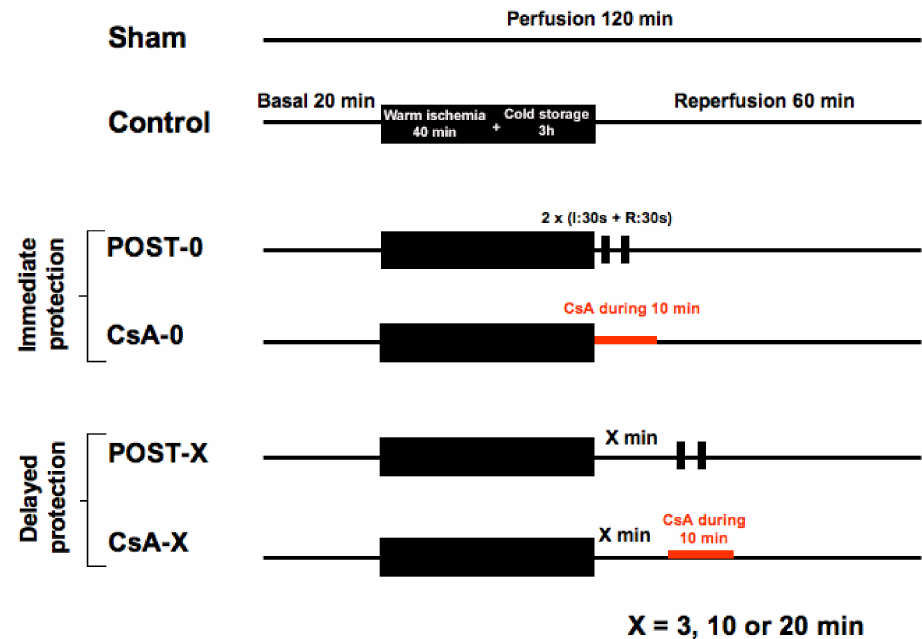
Figure 5. The experimental design included 10 groups of 12 animals. Sham underwent no ischemia reperfusion. All other groups experienced 40 min of ischemia followed by 60 min of reperfusion. POST-0 group (postconditioning without delay) consisted of two sequences of ischemia reperfusion at the onset of reperfusion. CsA-0 group (cyclosporin A at reperfusion without delay) involving CsA perfusion at 250 nM during the first 10 min of reperfusion. CsA and POST interventions were deferred for delayed groups by 3, 10, or 20